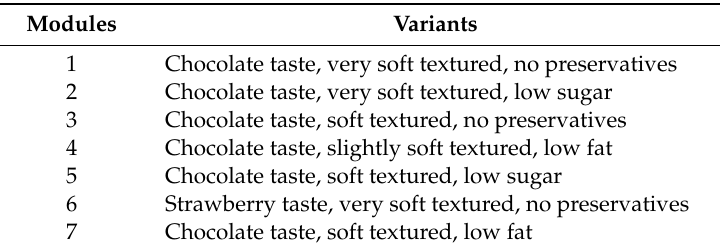
Table 11. Ice-cream